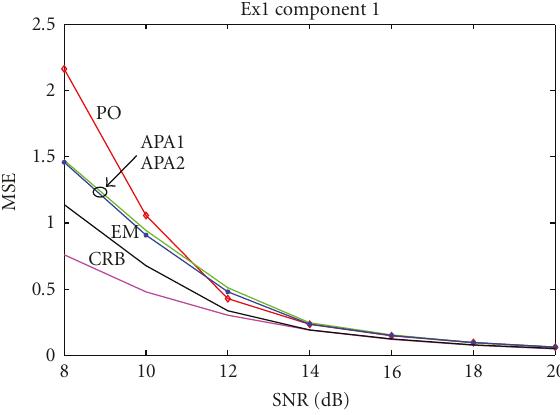
Figure 3: Experimental MSE versus SNR for Ex1 component 1.